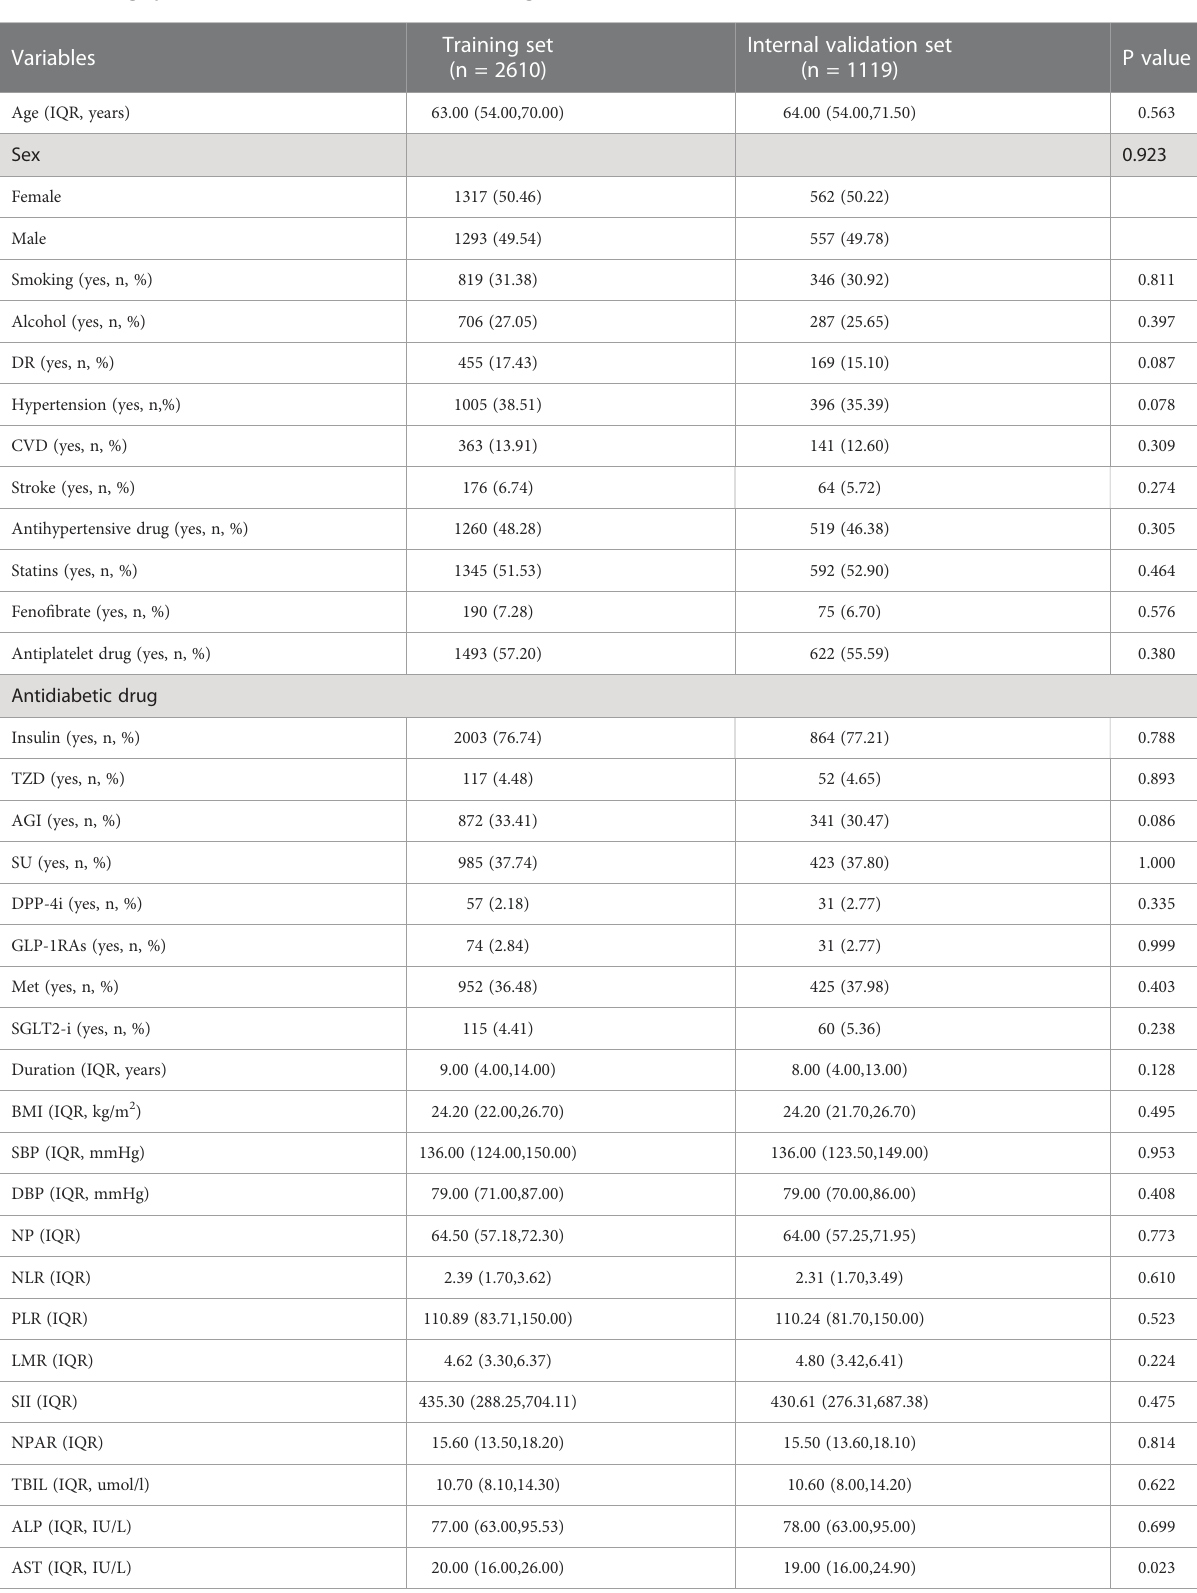
TABLE 1 Demographic and clinical characteristics of the training and internal validation